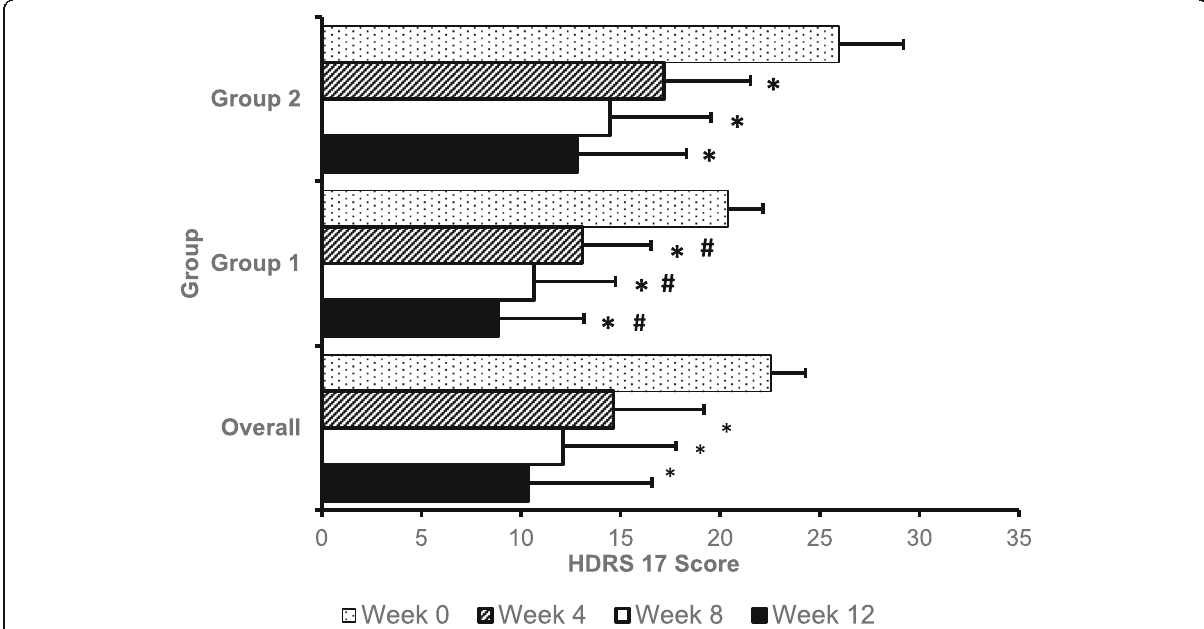
Fig. 2 Mean change in HDRS-17 scores with escitalopram therapy. Group 1: baseline HDRS-17 score between 18 and 23 ( n = 91).